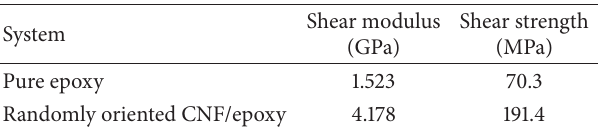
Table 3: Predicted shear moduli and failure strengths of the pure epoxy and CNF modified